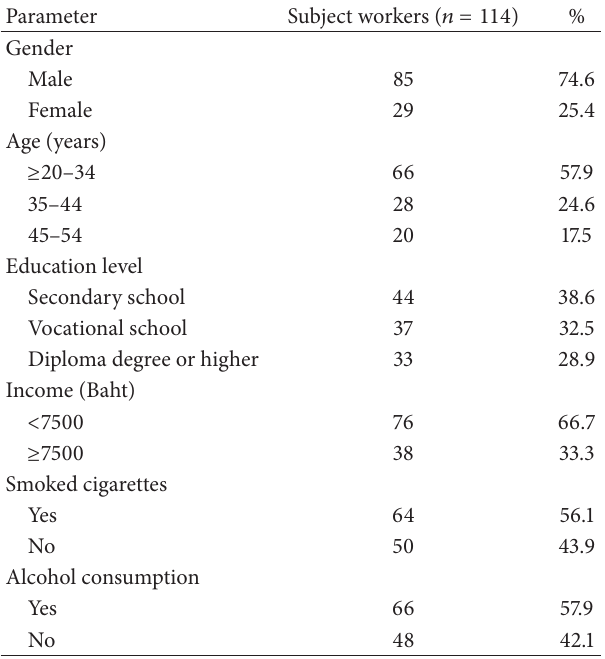
Table 1: General characteristics of the subject workers.